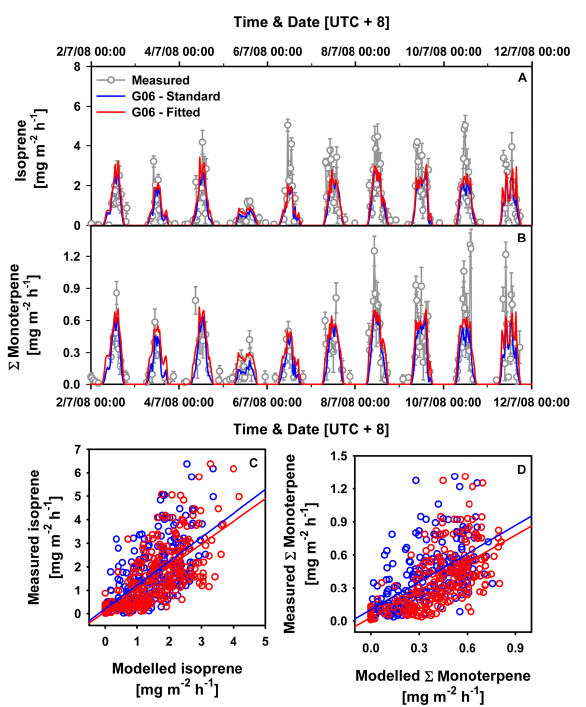
Fig. 8. Isoprene and monoterpene fluxes (grey line) measured by the virtual disjunct eddy covariance technique during the OP3-III field campaign. The blue line shows the model output when configured using the standard G06 coefficients and the red line shows the same output generated with empirically fitted parameters. Both sets of parameters, including basal emission rates normalised to 30 ◦ C and 1000µmolm − 2 s − 1 are listed in Table 3.